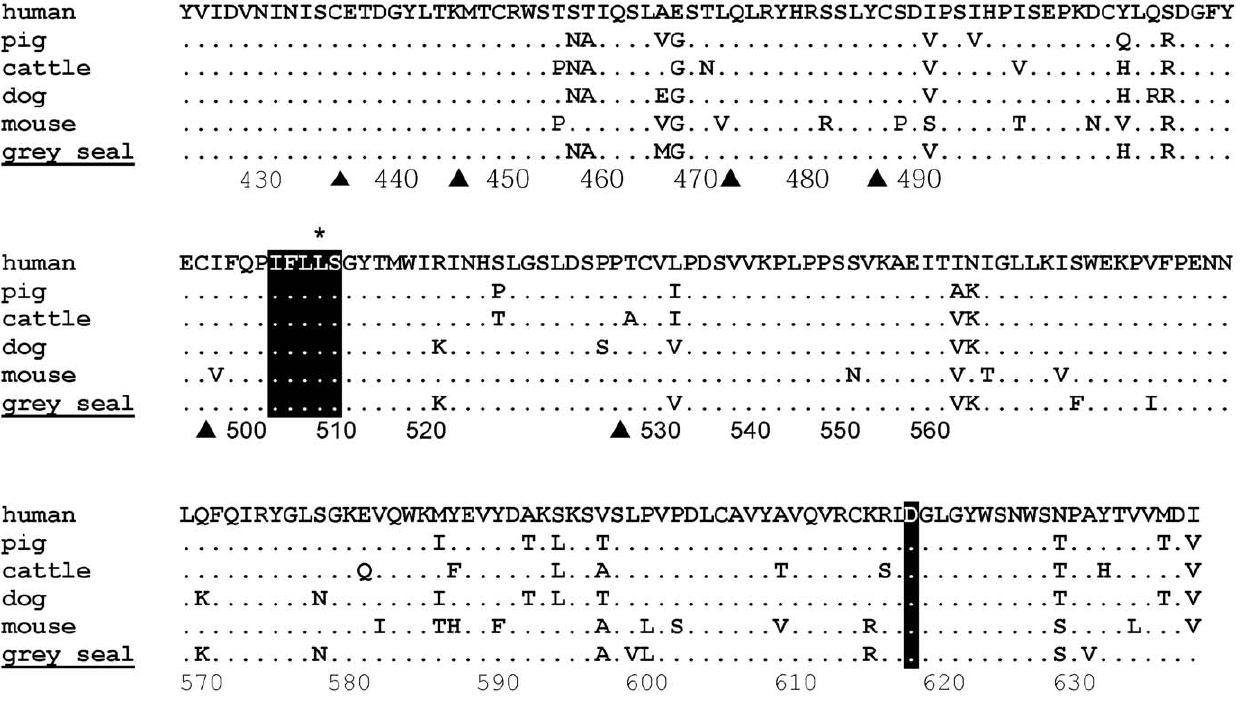
Figure 5. Conservation of the CRH2 region of the grey seal leptin receptor (LEPR) with selected terrestrial mammals. Identical residues to human LEPR are marked with a dot and residue numbering is according to human LEPR. Shading represents the residues critical for leptin binding, cysteine residues critical for folding are indicated by m and the most crucial residue for leptin binding is indicated by a ‘*’ above the alignment [24,25]. The grey seal LEPR sequence reported in this study is underlined.